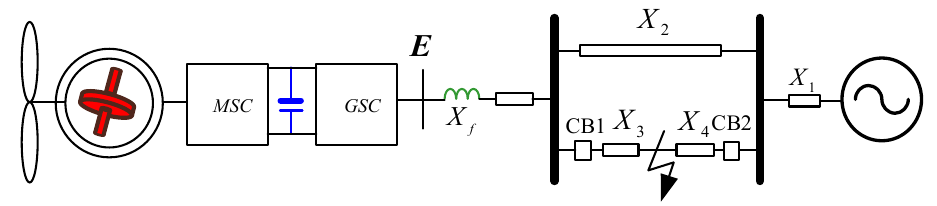
Figure 6. Single type-4 wind turbine infinite-bus (SMIB) system.